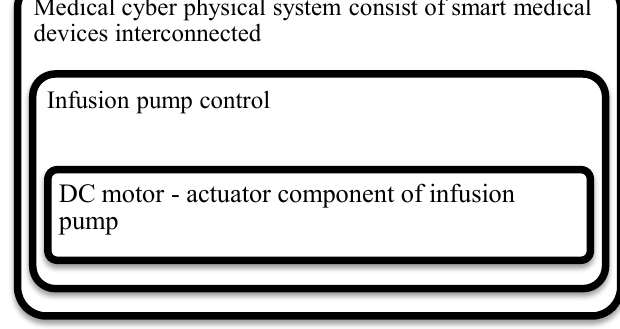
Figure 1. The overall objective of the